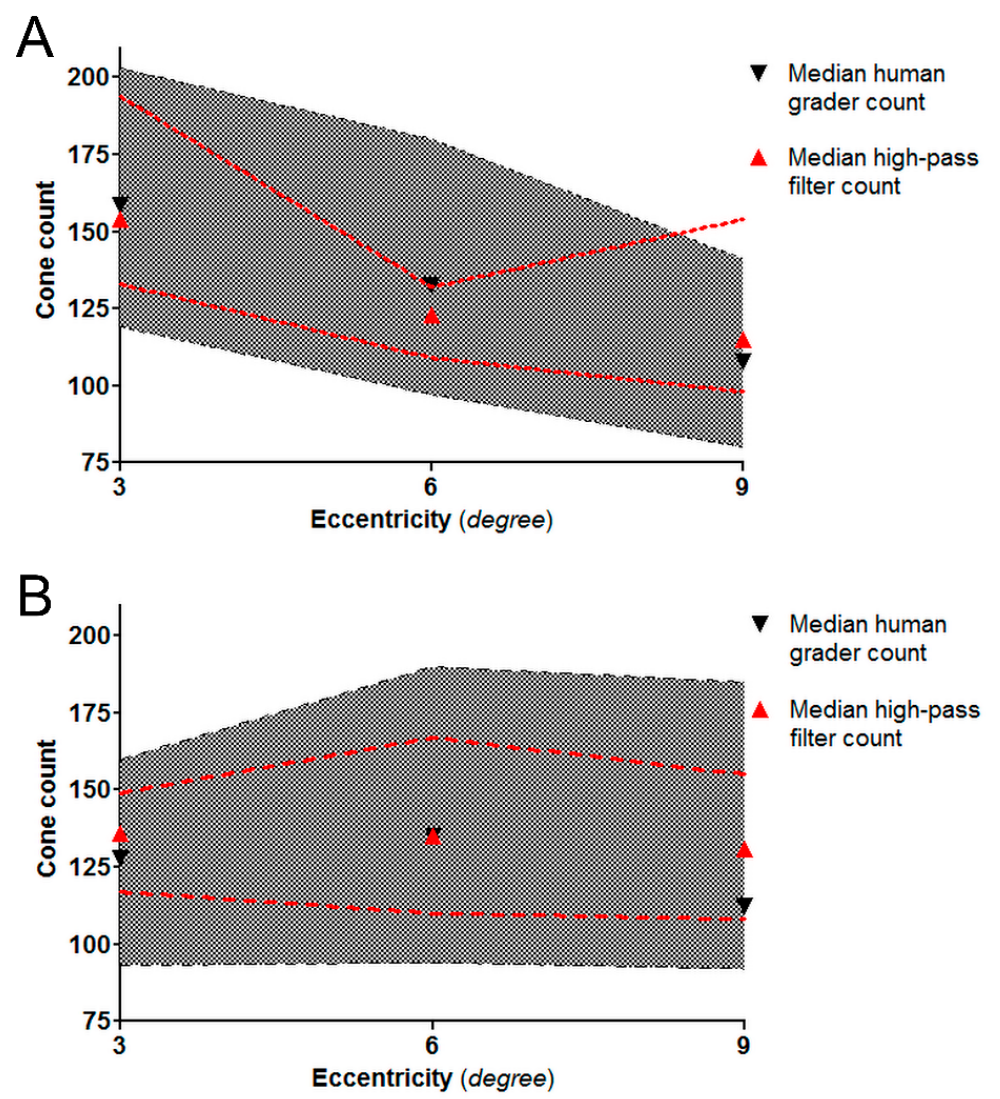
Figure 4. Median cone counts at 3, 6 and 9 degrees in healthy subjects ( A ) and CACD patients ( B ), according to human graders and automated high-pass filtered counts. Gray punctate areas indicate the range of cone counts according to human graders, and red upper and lower segmented lines represent the range of cone counts according to high-pass filtered cone counts.